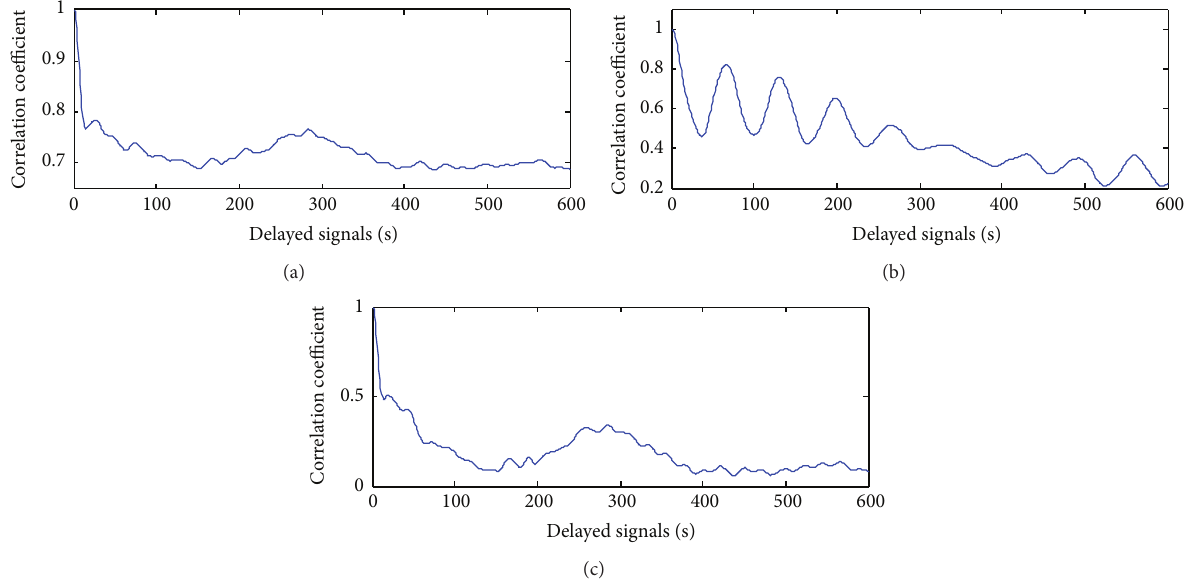
Figure 10: Correlation coefficient for each target RMS. (a) corresponds to the correlation in the first band, RMS 𝑍1 , (b) to RMS 𝑍2 , and (c) to RMS 𝑍3 .